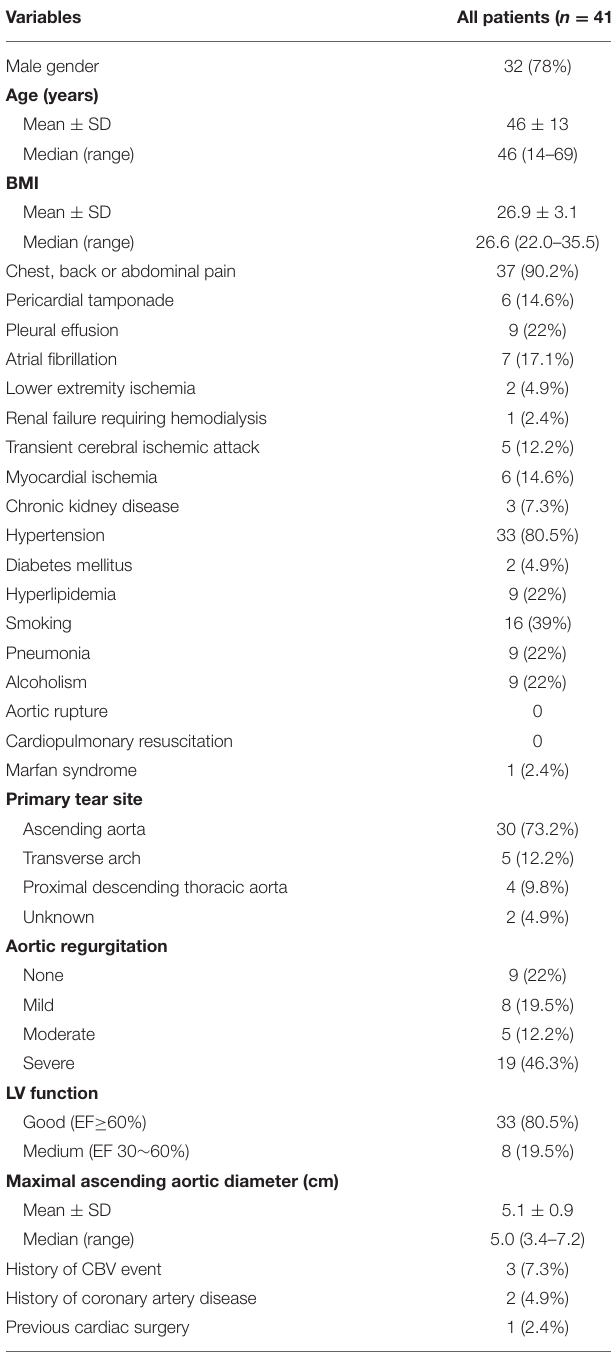
TABLE 1 | Preoperative and presentation